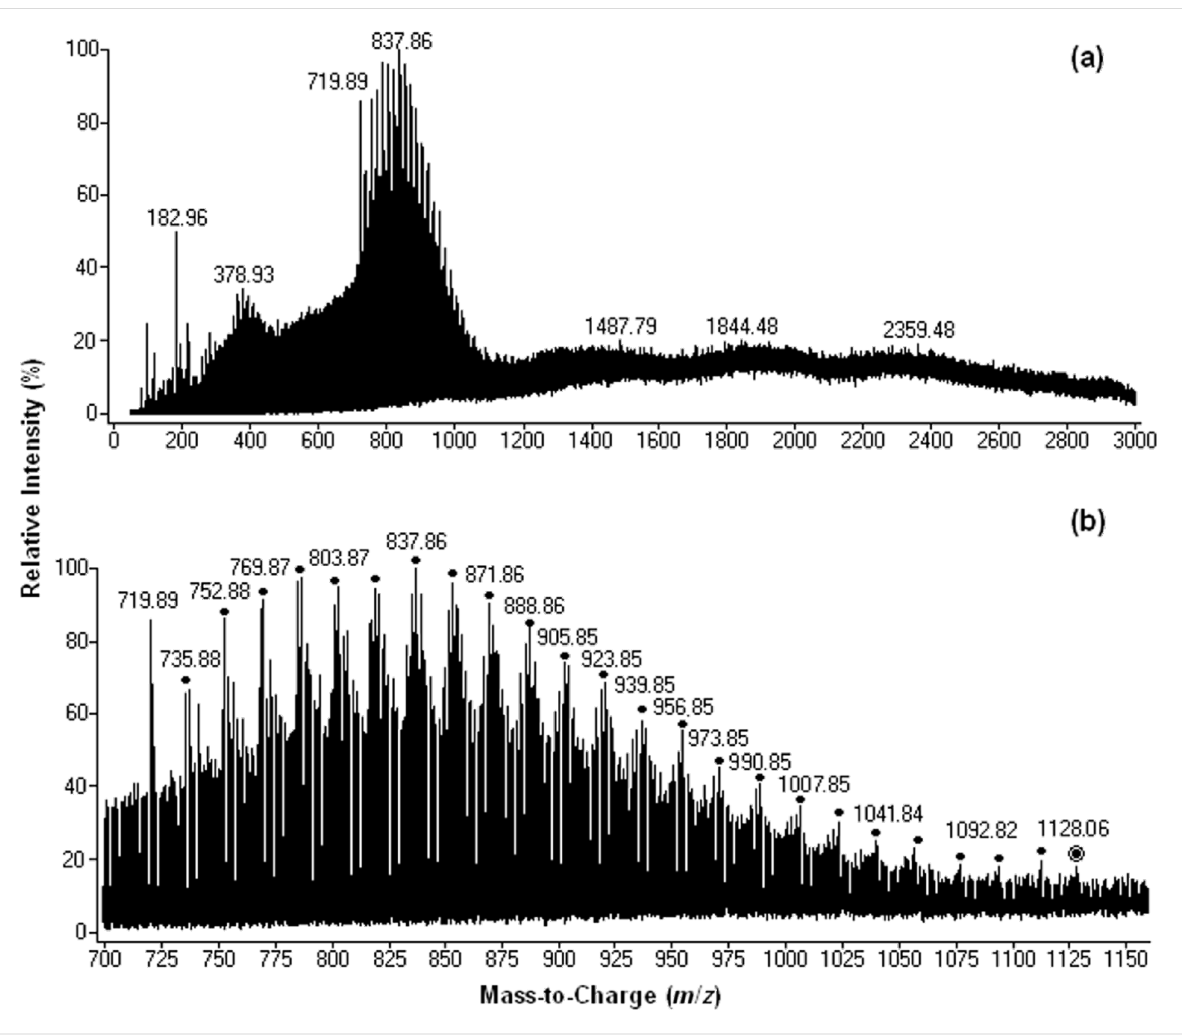
Figure 2: Negative-ion mass spectra of a 0.5 × 10 − 5 M aqueous solution of C 60 (OH) 24 in ammonia solution: (a) full scan spectrum; (b) m / z ranges of